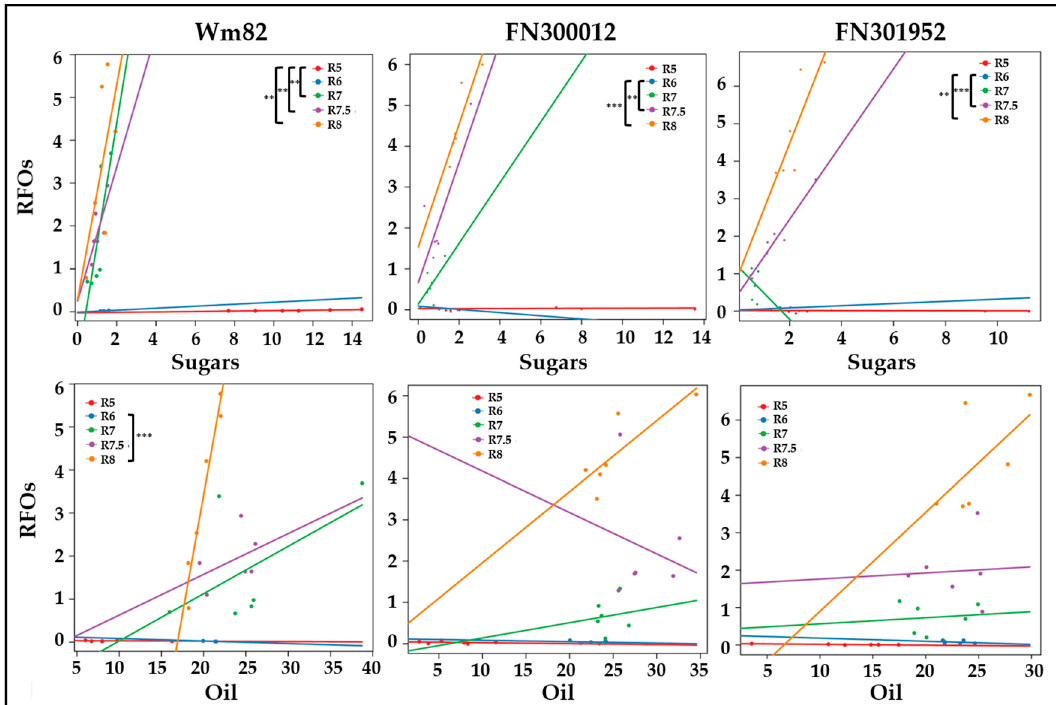
Figure 5. Linear models between sugars and RFOs (top panel) or oil content and RFOs (bottom panel) represented by regression lines, color coded for developmental time points (R5–R8). Statistically significant differences in slopes between time points that represent a change in the direction of carbon flow are marked for each of the three lines, namely Williams 82, FN300012, and FN301952. ** p < 0.01 and *** p < 0.001. Units for both axes represent % biomass. Sugars represent the sum of glucose, fructose, and sucrose. RFOs represent raffinose and stachyose together.